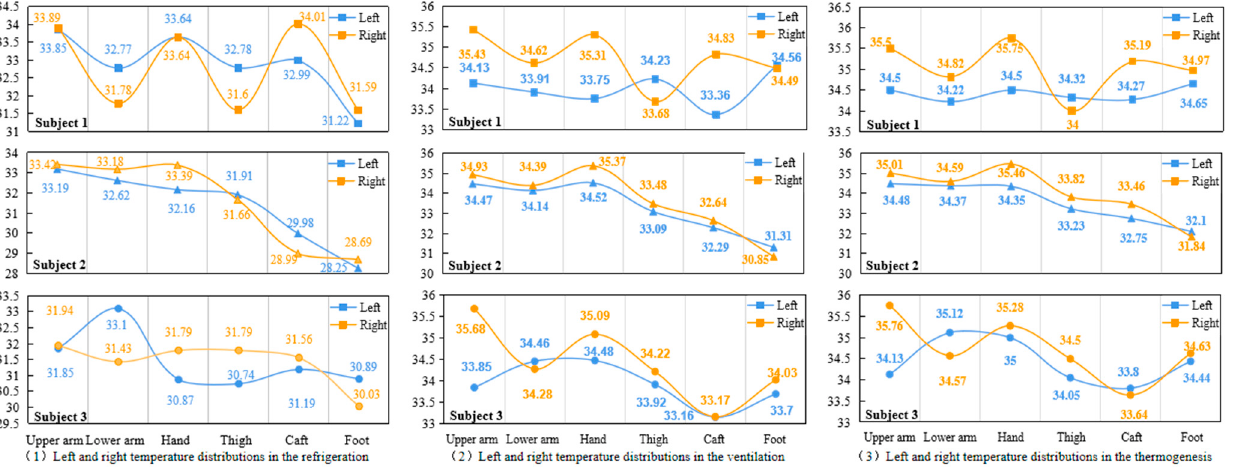
Figure 14. The temperature differences between left and right body parts were observed under different ventilated conditions wearing short clothing.